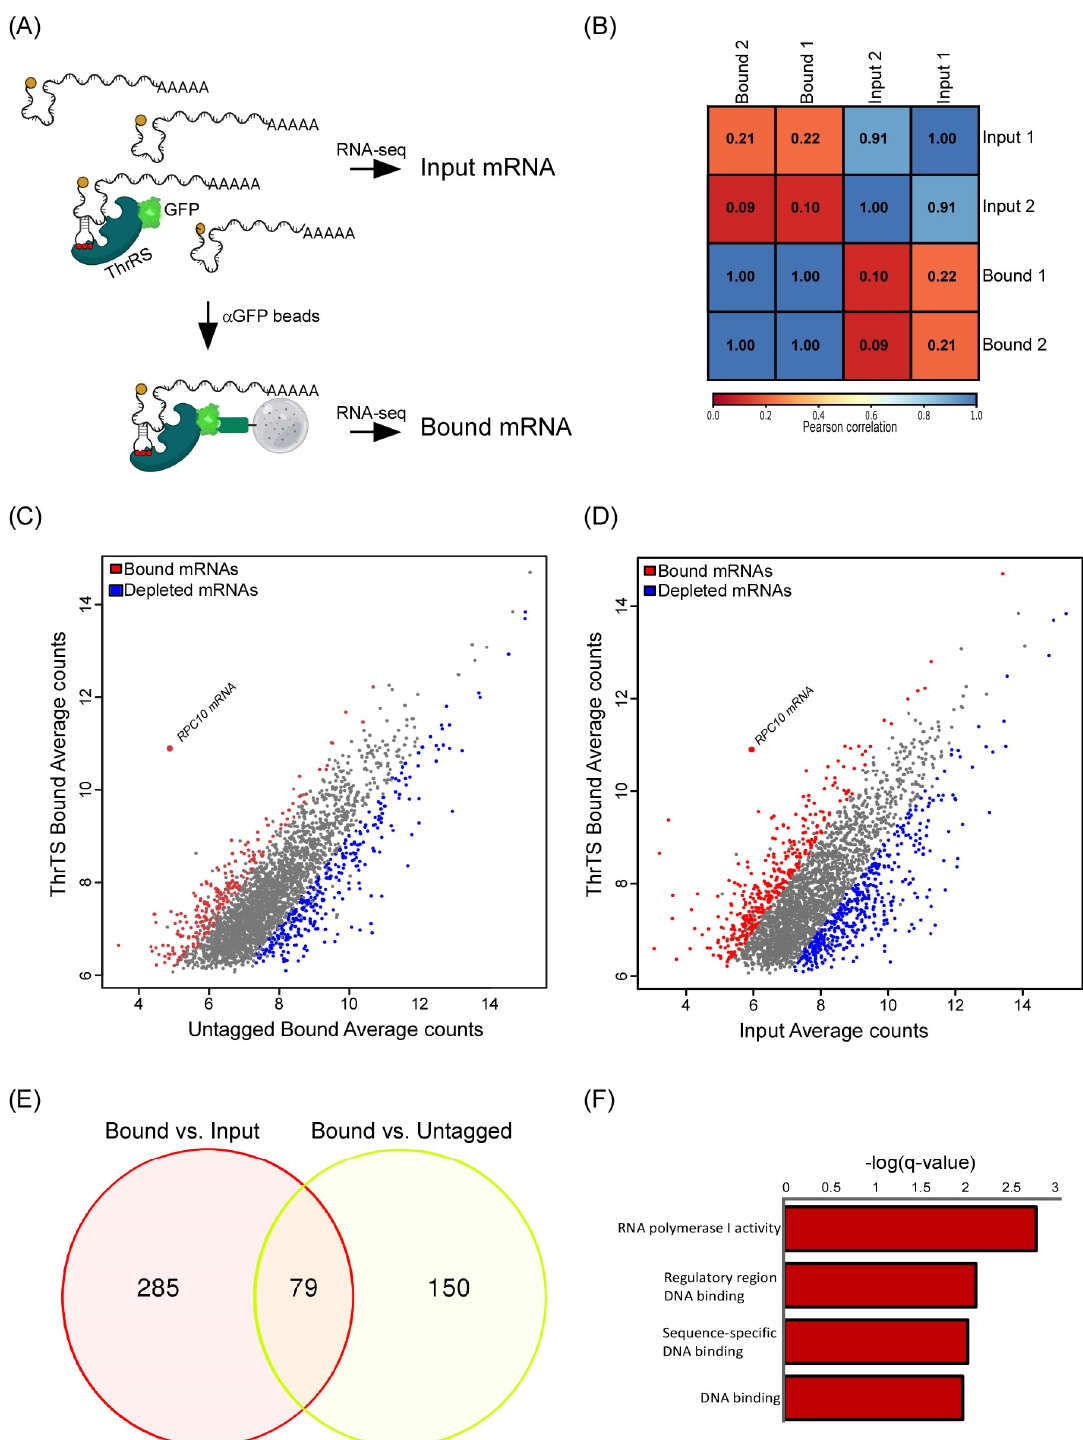
Figure 1. ThrRS mRNA binding analysis. ( A ) Scheme of the RIP ‐ seq protocol. GFP ‐ trap beads were used to isolate ThrRS ‐ bound mRNAs from cell lysates of GFP ‐ tagged ThrRS and untagged control strains. Bound and Input mRNA were subjected to RNA ‐ seq. ( B ) Pearson correlation matrix between biological repeats and samples. ( C ) Scatterplot of mRNAs Bound signals in ThrRS ‐ GFP vs. the untagged ThrRS control. Red dots indicate mRNAs significantly enriched (fold enrichment >2 and adjusted p ‐ value < 0.05), blue dots represent depleted mRNAs, and grey dots represent back ‐ ground mRNAs. ( D ) Scatterplot of mRNAs signals in the Bound vs. Input samples. Coloring as in ( C ). ( E ) Venn diagram was generated from significant Bound mRNAs compared to the Input (Red circle) and from significant Bound mRNAs compared to the Bound in the untagged control (yellow